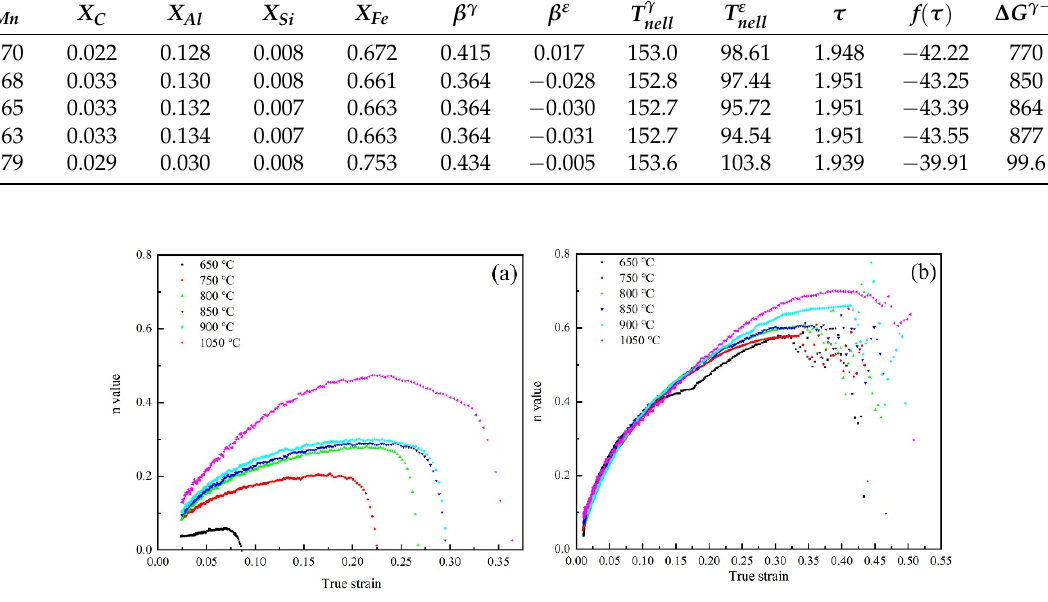
Figure 9. Instantaneous strain hardening exponent as a function of true strain for steels under solid solution treatment at different temperatures: ( a ) steel 1# and ( b ) steel 2#.